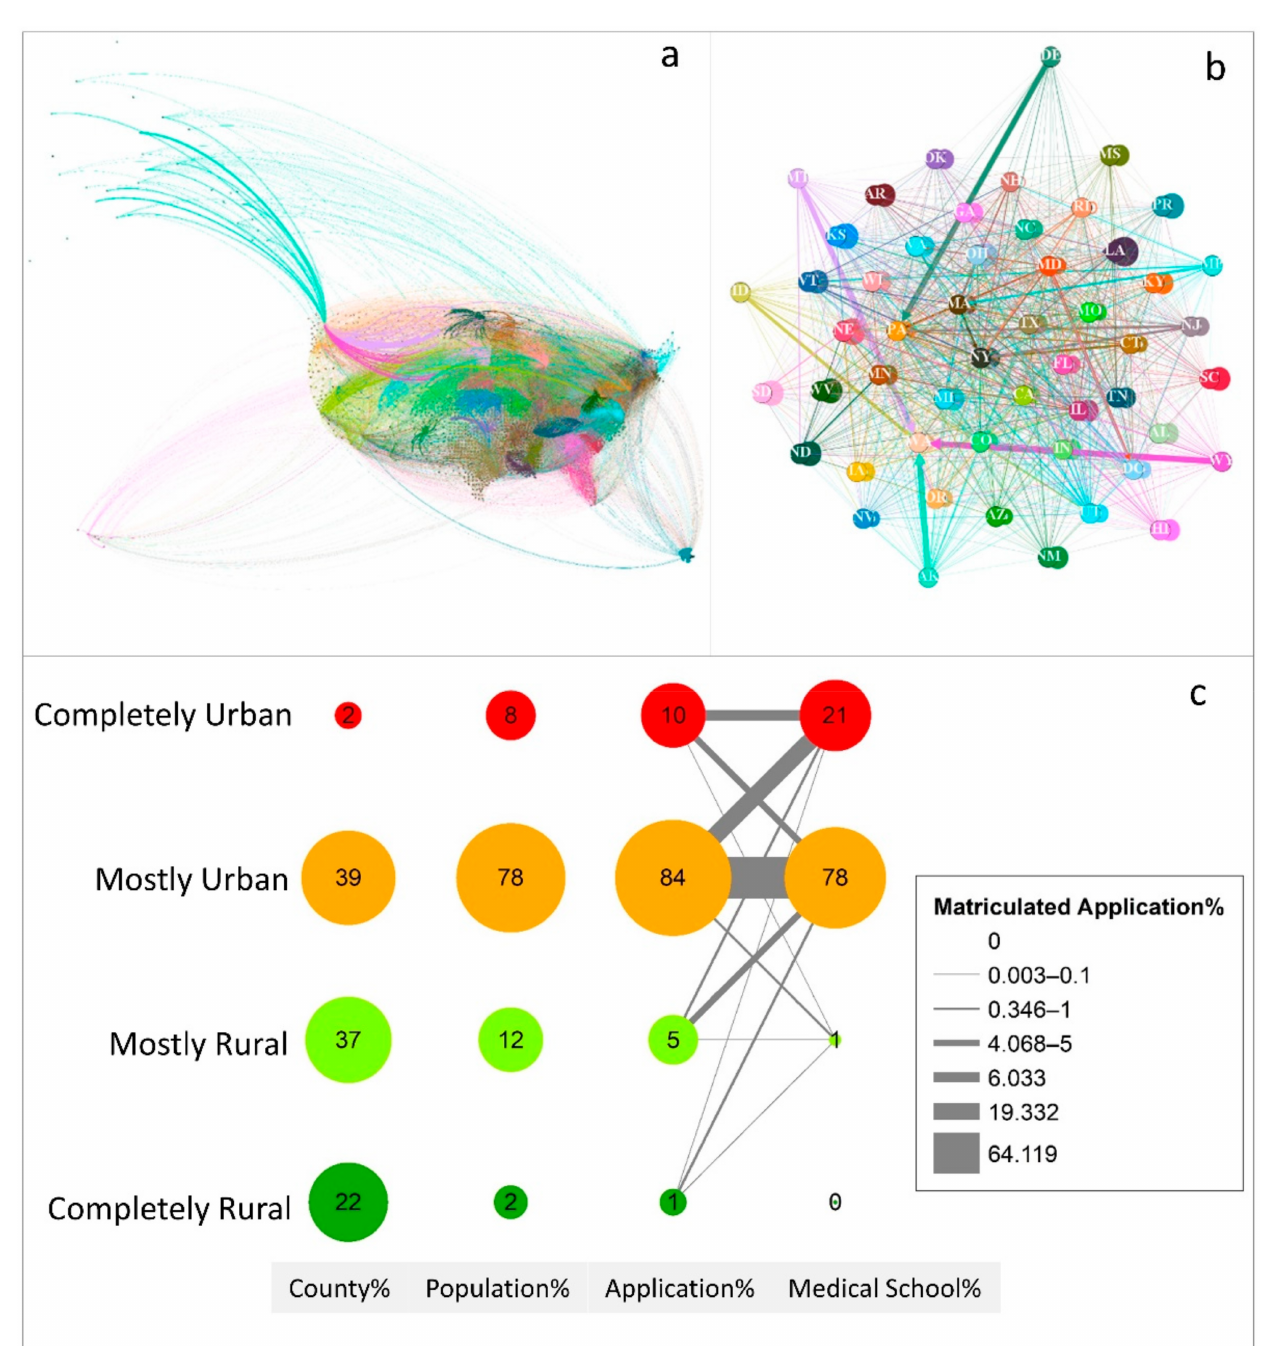
Figure 5. ( a ) County-level application trajectories 2001–2015. ( b ) State-level Fruchterman–Reingold Layout and ( c ) concep- tual